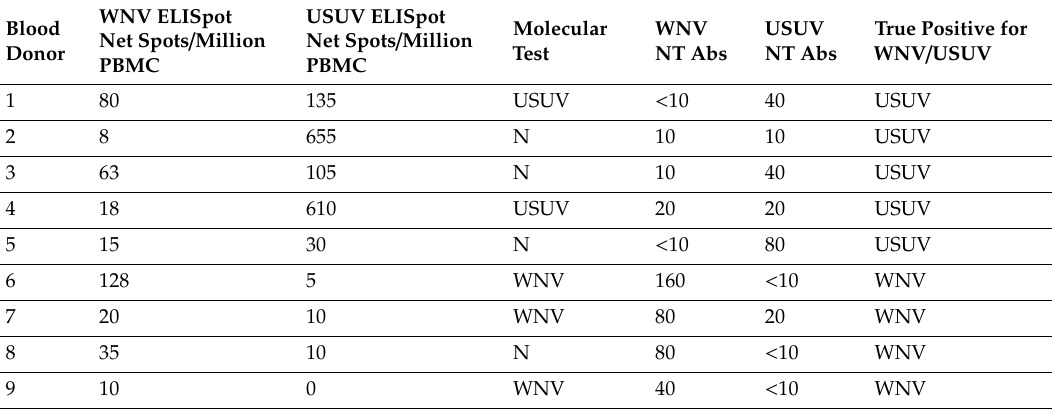
Table 3. ELISpot comparative results in five USUV true positive and four WNV true positive blood